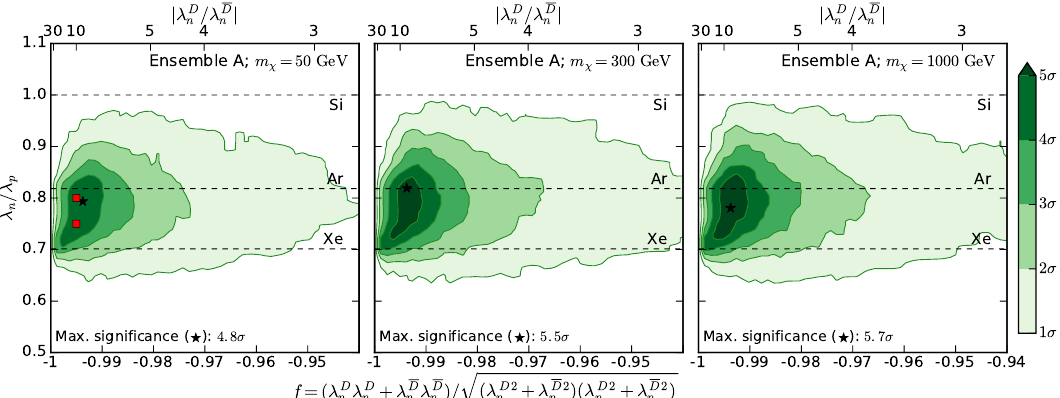
Figure 1 . Median signi(cid:12)cance for discriminating Dirac from Majorana DM using ensemble A (Xe + Ar + Si). Signi(cid:12)cance with which Dirac DM can be distinguished from Majorana DM using experimental ensemble A. Each panel shows the results for a di(cid:11)erent DM mass: 50 GeV, 300 GeV and 1000 GeV (from left to right). Dashed horizontal lines show where (cid:21) n =(cid:21) p = N p =N n for the di(cid:11)erent targets in the ensemble. Along these lines (and close to f = (cid:0) 1), we expect maximal cancellation of the DM-nucleus cross section for each nucleus respectively. The parameter point with maximum discrimination signi(cid:12)cance is marked with a star. The parameters (cid:21) p and (cid:21) n are de(cid:12)ned in eq. (2.4) and eq. (2.5). The red squares in the left panel denote the parameter points which are examined further in (cid:12)gure